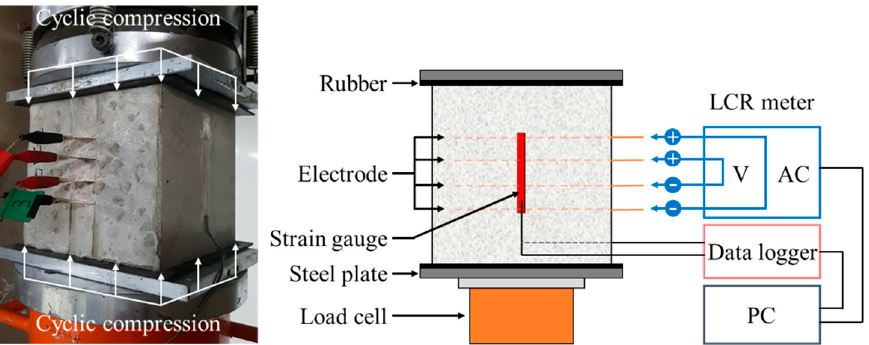
Figure 4. Test setup of self ‐ sensing under cyclic compressions.